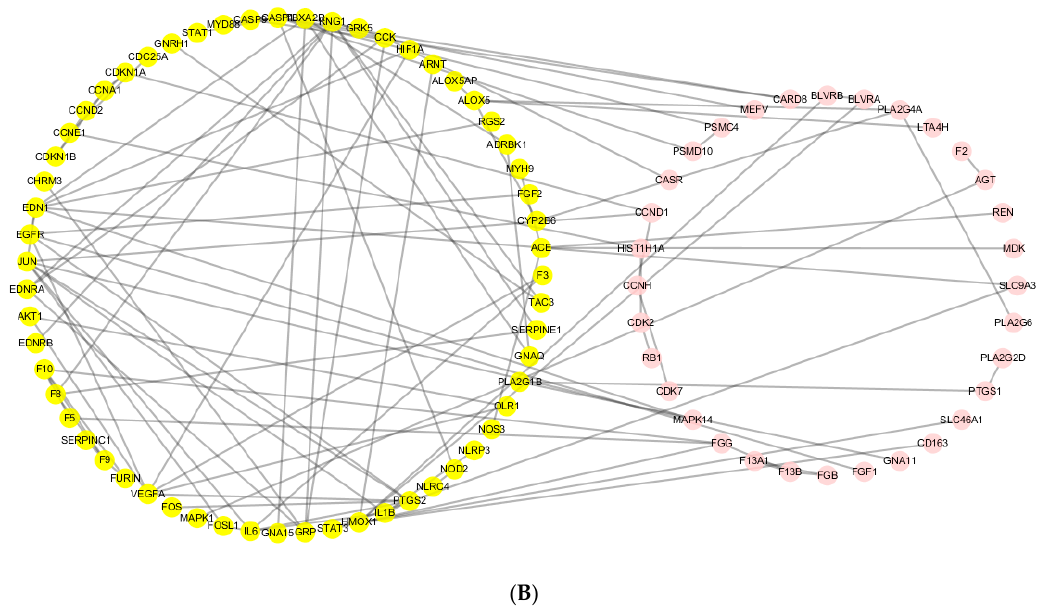
Figure 2. ( A ) Coexpression protein interaction networks (CePIN) in a non-CHD state (non-CHD CePIN) and ( B ) coexpression protein interaction networks (CePIN) in a CHD state (CHD CePIN). Nodes in green color are unique nodes in non-CHD CePIN; those in yellow color are shared nodes both in non-CHD CePIN and CHD CePIN; those in pink color are unique nodes in CHD CePIN; and the blacklines are interactions between nodes.